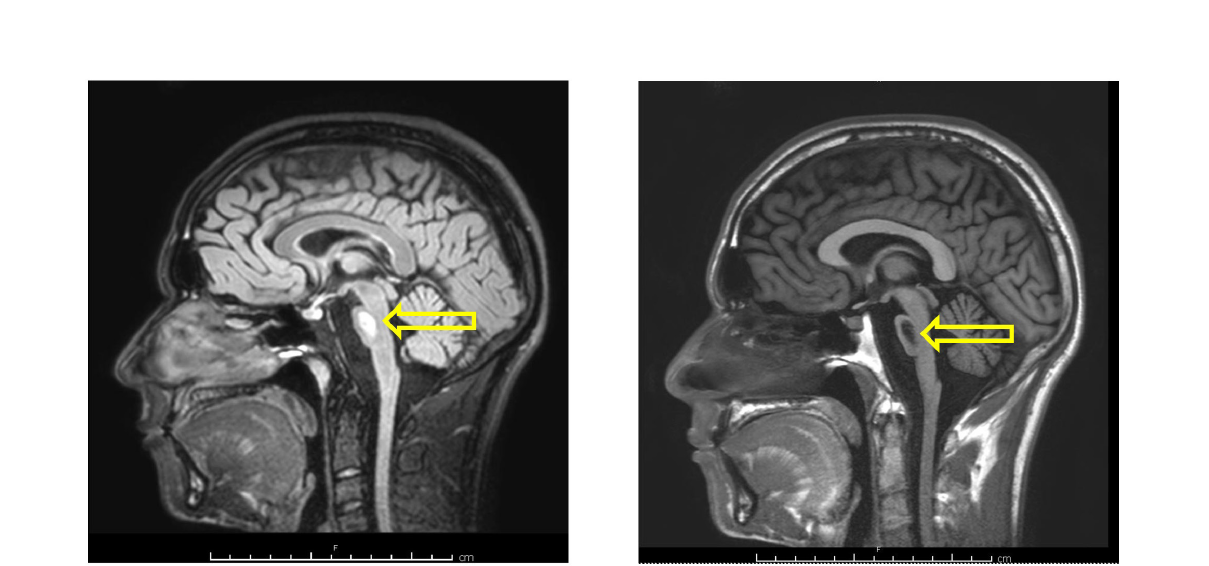
Figure 1. MRI scan of brain: signal abnormalities in the central part of the pons. Hyper-intense pontine lesions on long TR sequence (on left), hypo-intense on T1 scans (on right)